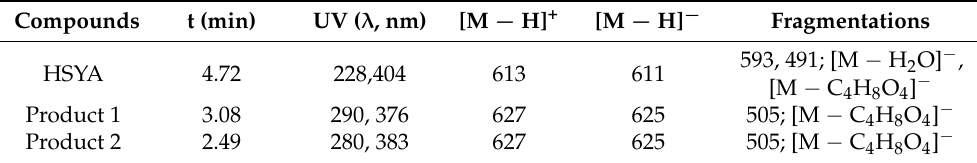
Table 3. Mass, UV and UPLC retention time of HSYA and the products.